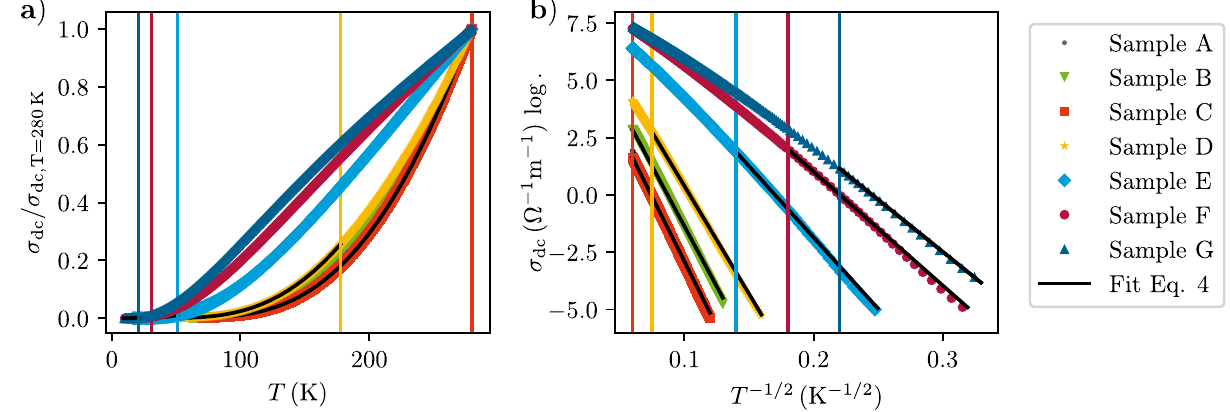
Figure 1. ( a ) DC conductivities of samples A to G normalized to σ DC at T = 280 K . Vertical lines correspond to the upper limit of the validity range of the cVRH-behavior. ( b ) DC conductivities of the samples in log σ DC vs. T − 1 / 2 representation making the temperature range of validity for cVRH-behavior apparent. Fit results are presented in Table 1.